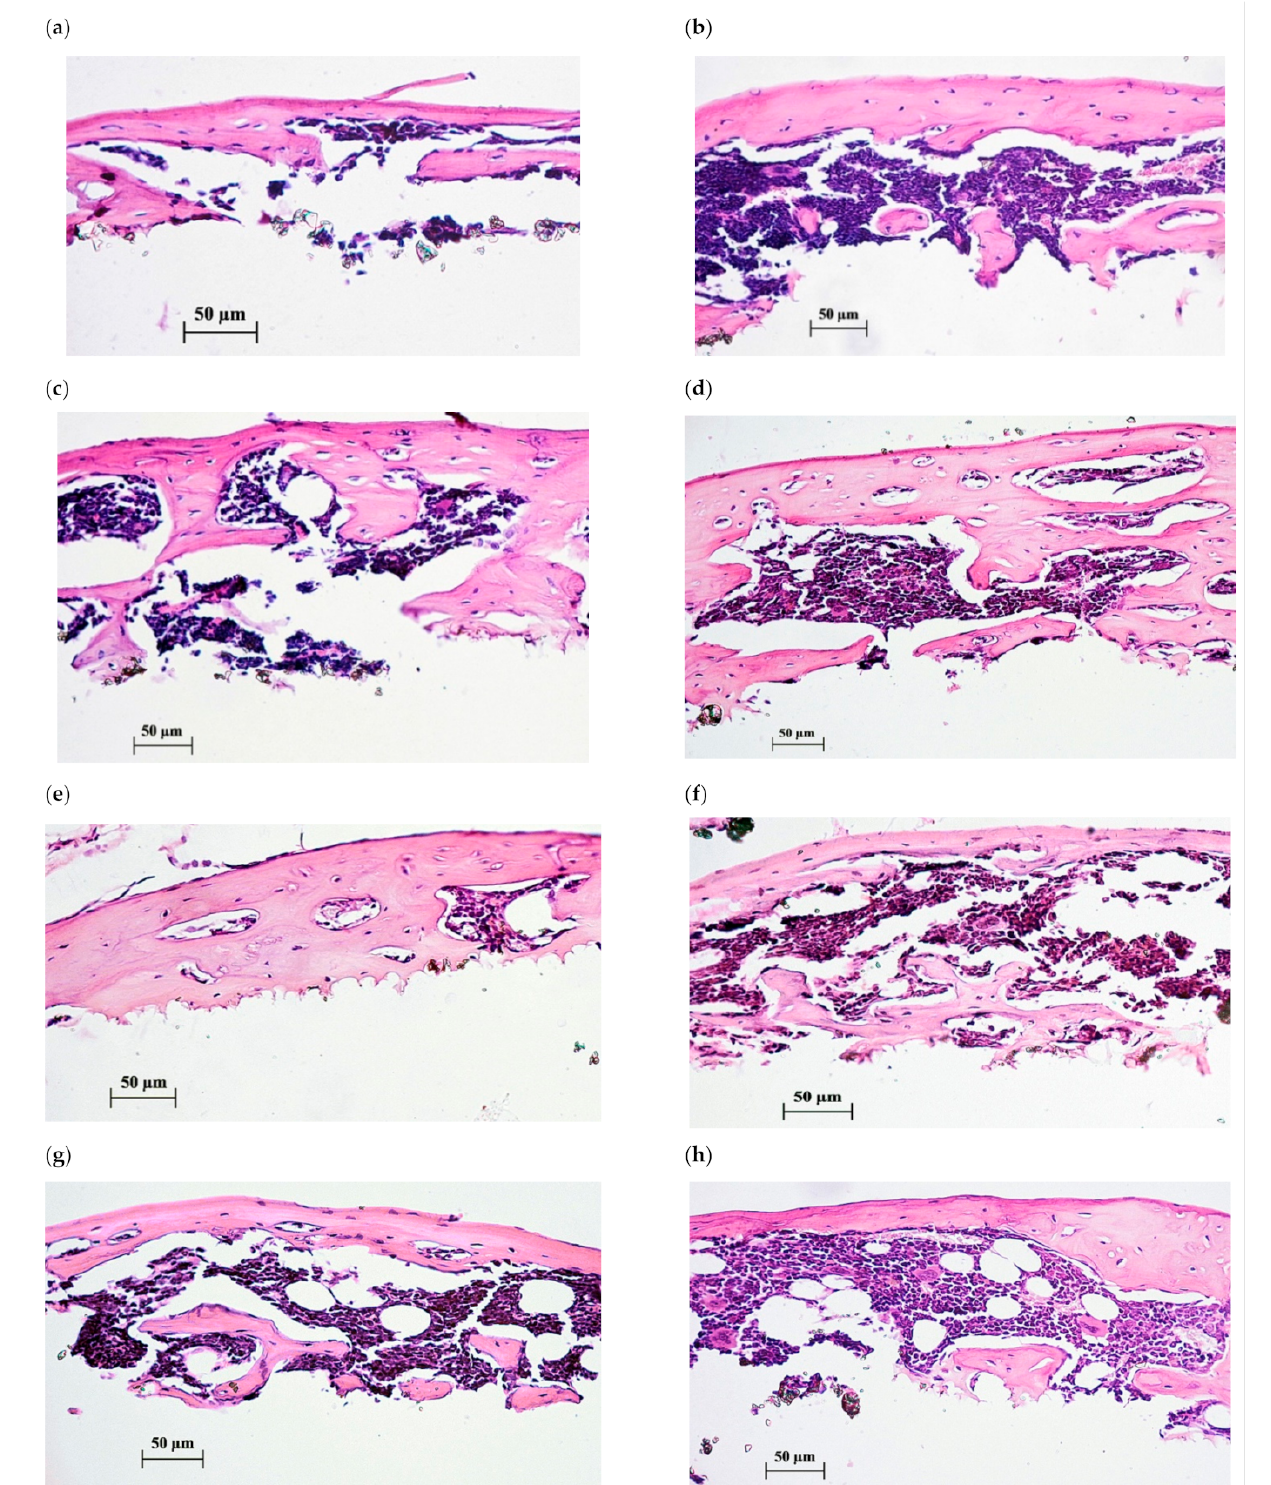
Figure 4. Histological sections of tissue lamellae grown on CaP-coated Ti substrates after 45 days of subcutaneous test in mice. Bone tissues with marrow are shown after 35-day peroral administration of water solvent ( a – c ) or 10 mg/L of CaChA in water solution ( d – h ). Hematoxylin–eosin staining. Magnification × 200. Scale bars 50 µ